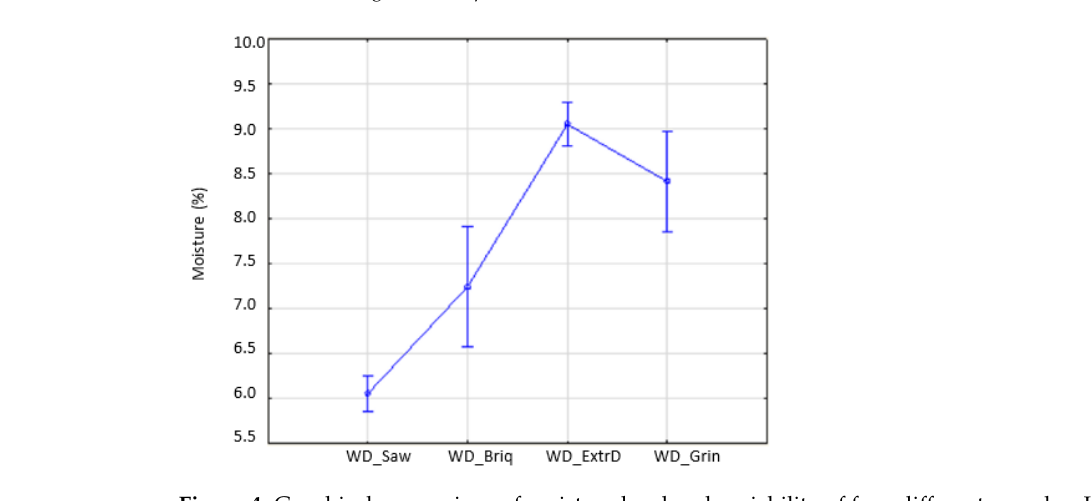
Figure 4. Graphical comparison of moisture level and variability of four different samples. Legend: “x” axis—dust samples.